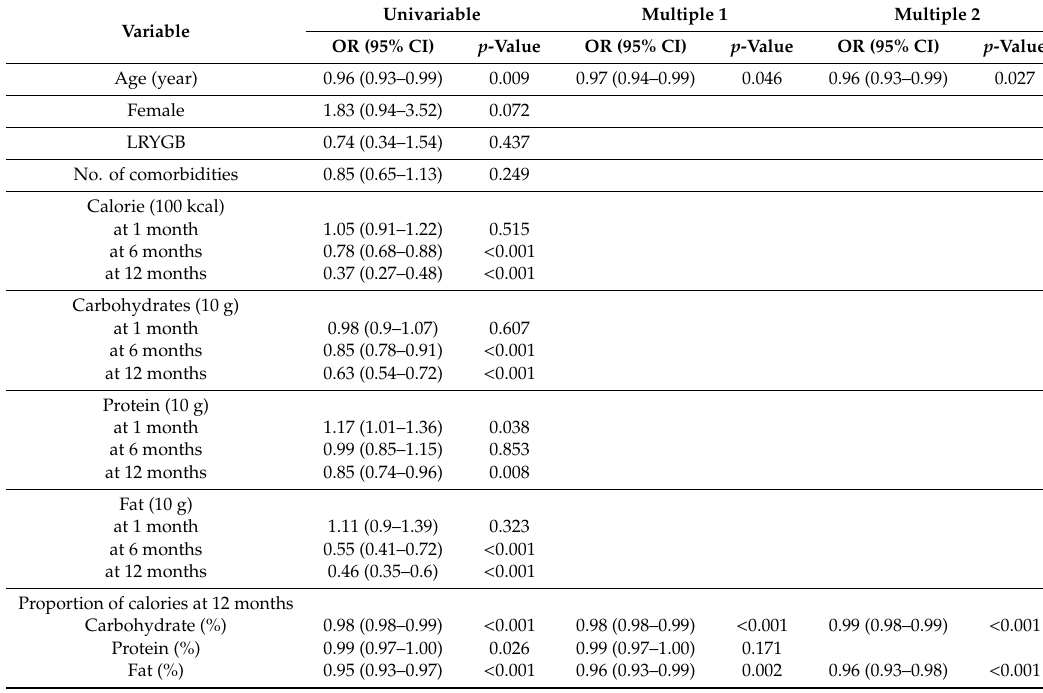
Table 4. Logistic regression analysis for the success in